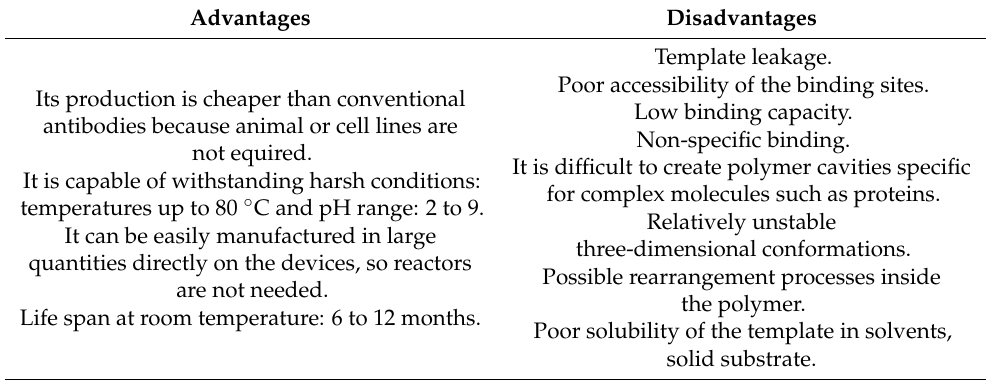
Figure 2. Development process of molecularly imprinted polymers: ( 1 ) Selection of the target molecule; ( 2 ) functionalized monomers are added to the target molecule to assemble the pre-complex; ( 3 ) polymerization primers and cross-linkers are added, and co-polymerization occurs at the estab- lished conditions to generate the polymer complex; ( 4 ) the template is removed using a washing buffer; ( 5 ) the polymer complex is attached to the surface of the biosensor. Table 3. Advantages and disadvantages of molecularly imprinted polymers [17 – 20].